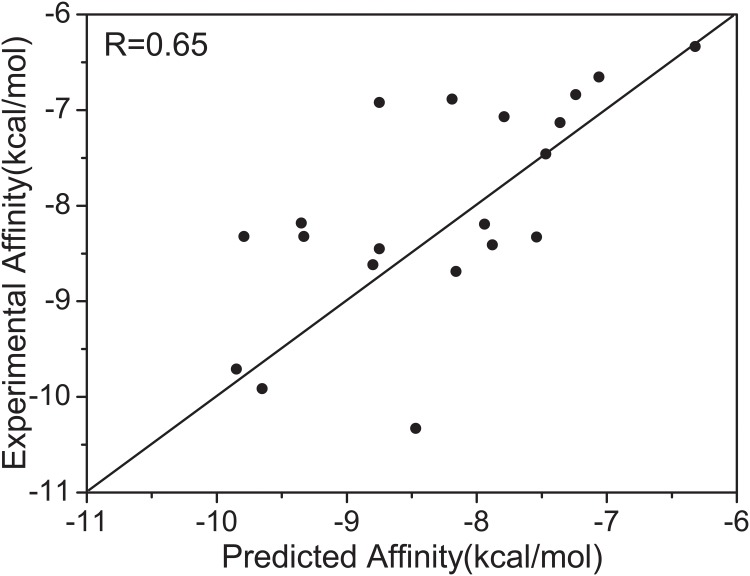
Validation of Autodock scoring to predict the binding affinities for 20 drugs against the Cox-2.